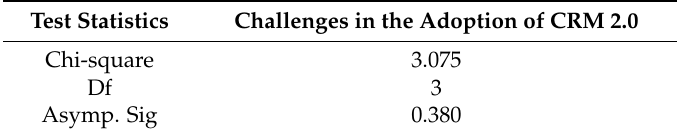
Grouping variable: organization